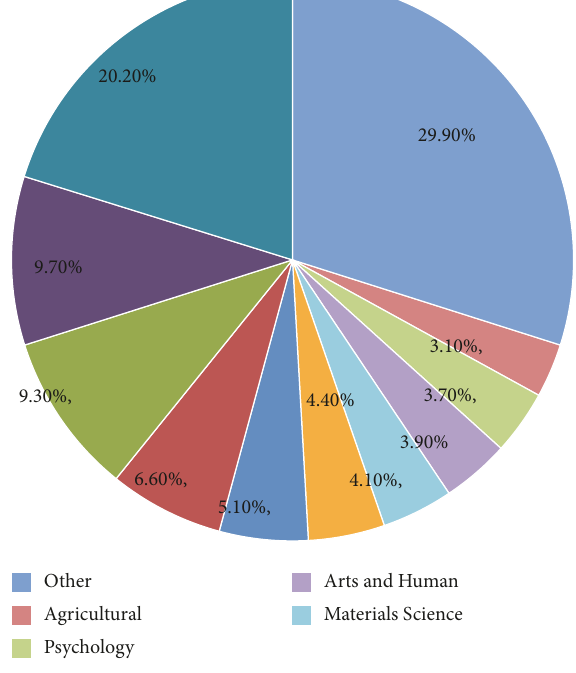
Figure 16: Pie chart depicting article distribution by disciplines for critical review articles.